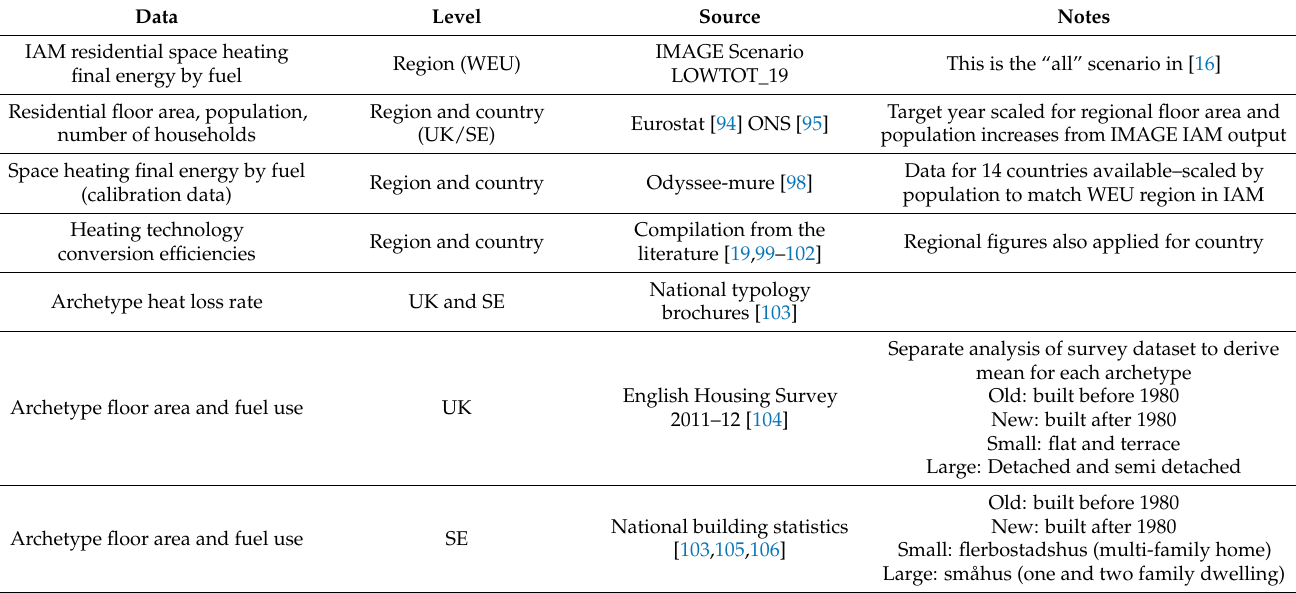
Table A3. Data sources for heating